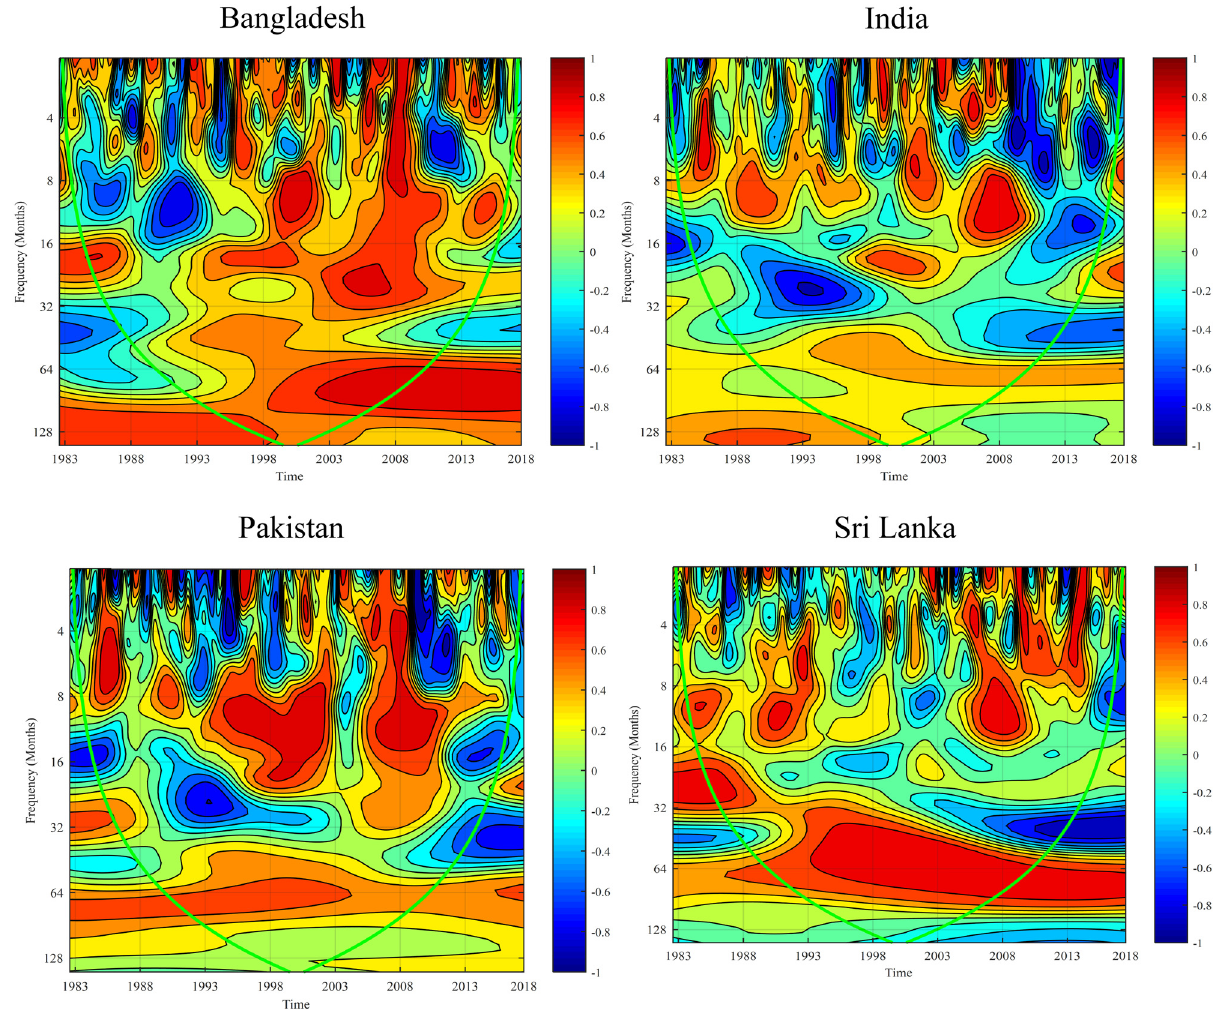
Figure 4: Wavelet - based correlations ( Rua, 2013 ) between oil price and exchange rates. Note: The color code shows strength of correlation. Blue ( read ) color indicates negative ( positive ) correlation between variables.